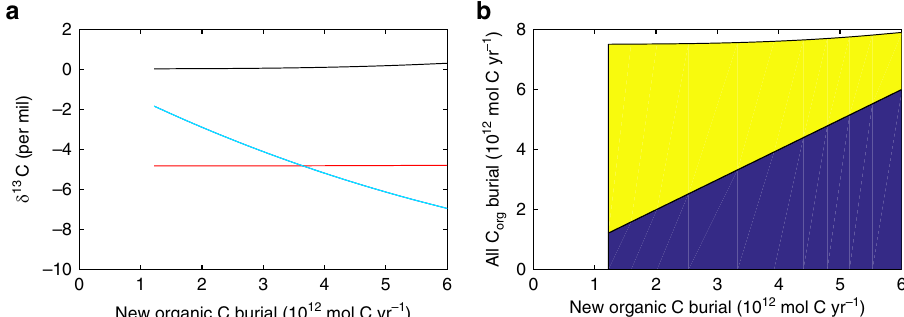
Figure 5 | Steady-state response of carbon isotopes to changes in organic carbon burial. Results from the Precambrian COPSE model (see ‘Methods’ section). ( a ) d 13 C for degassing input (red), carbonate carbon burial (black, d 13 C carb ) and total inputs/outputs to the surface DIC pool (cyan), which balance one another at steady state. ( b ) New (blue) and detrital (yellow) contributions to total organic carbon (C org )